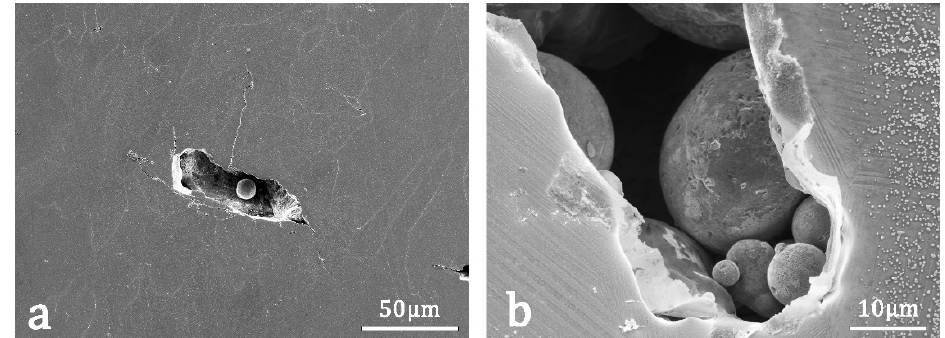
Figure 6. ( a ) SEM–SE image, taken in the SM–1 sample, of the porosity due to lack of fusion associated with a low local surface energy. ( b ) Another similar image in sample SM–1, showing not only the porosity but also the precipitates produced during LPBF processing.